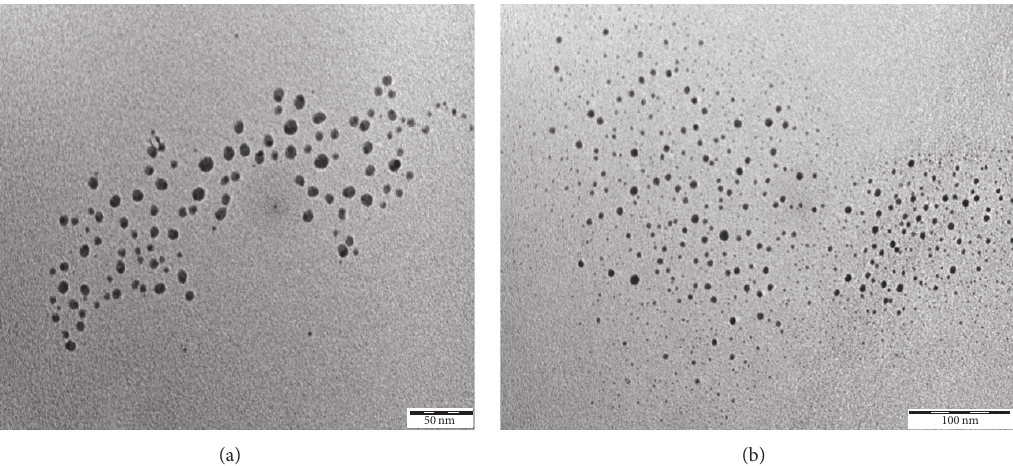
Figure 5: TEM images of (a) silver nanoparticles at energy of 700 mJ for 10ns pulse duration and (b) silicon nanoparticles at energy of 700 mJ for 10ns pulse duration.